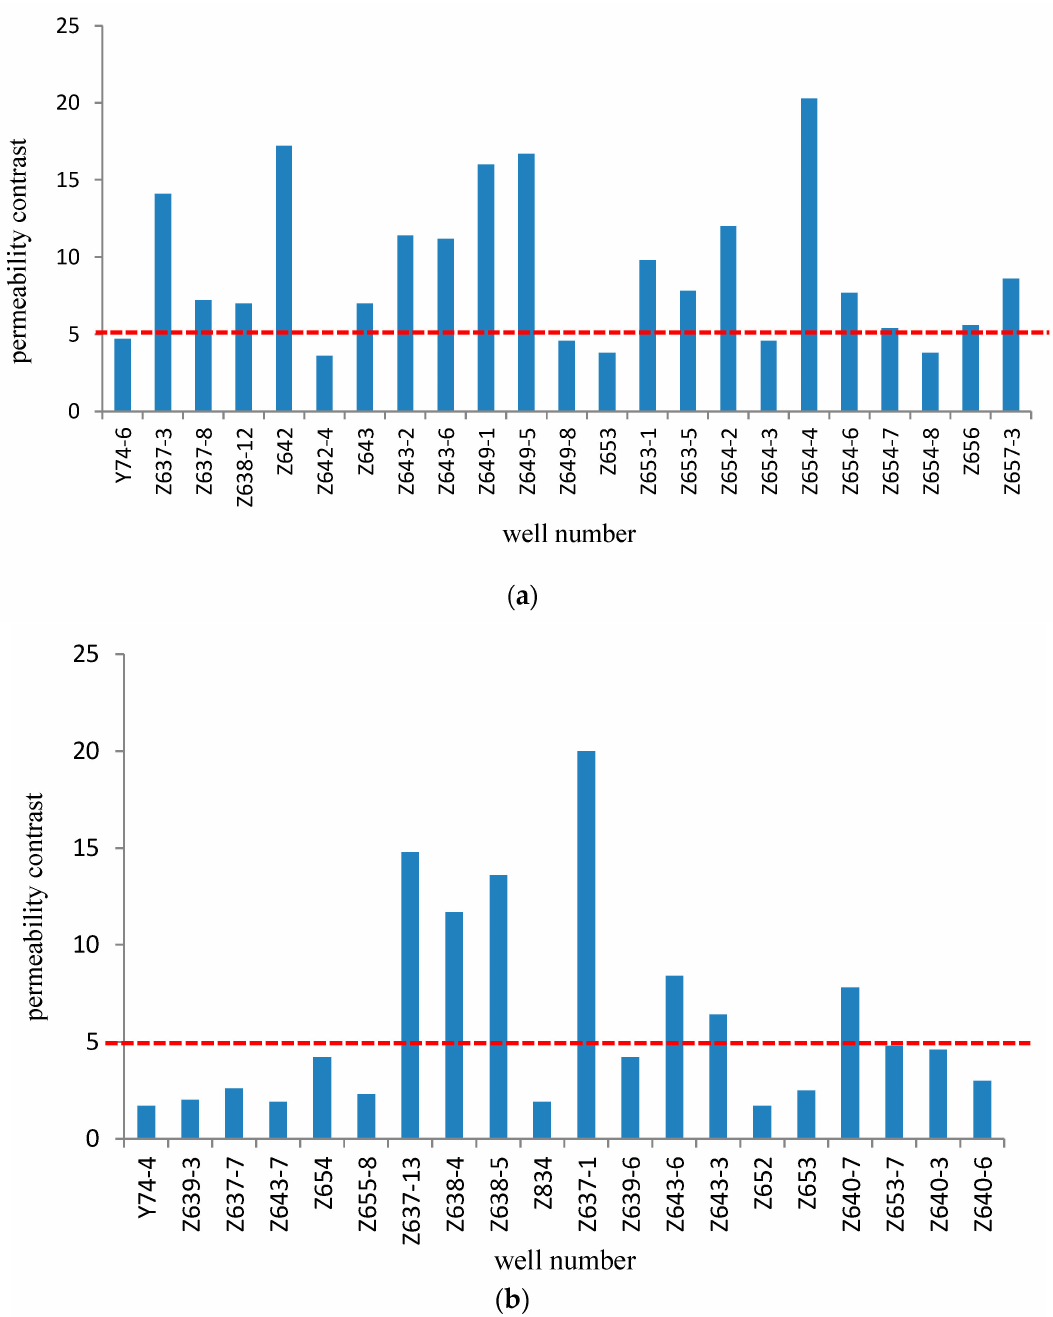
Figure 10. Distribution histogram of the permeability contrast in wells with water channeling ( a ) and without water channeling ( b ). Red dotted line means the value of permeability contrast is